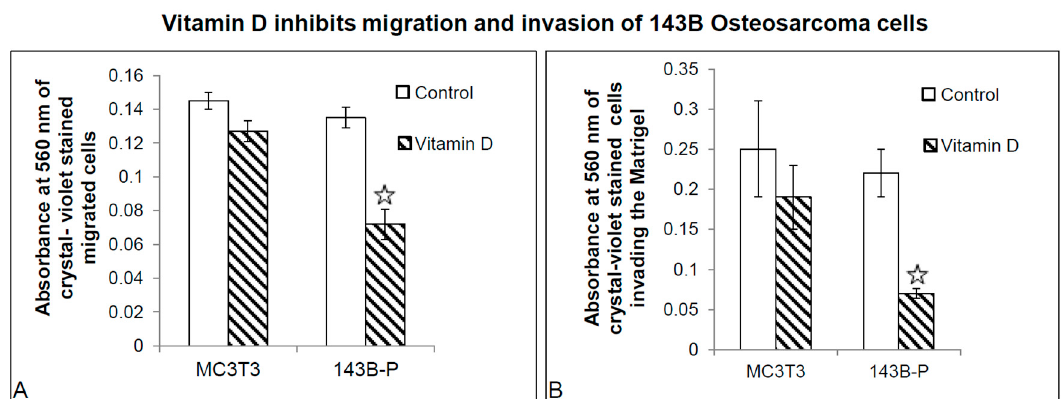
Figure 8. Comparative effect of 1 α ,25(OH) 2 D 3 on migration and invasion of 143B human OS cells vs. MC3T3, pre-osteoblast cells. Migration ( A ); and invasion ( B ) of 143B (P denotes parental 143B human OS cell line as obtained from ATCC) and MC3T3 cells was evaluated by quantifying crystal violet staining of migrated/invaded cells through the membranes in transwell chamber assays by monitoring a change in the absorbance at 560 nm. Star indicates statistical significance * p ≤ 0.05.